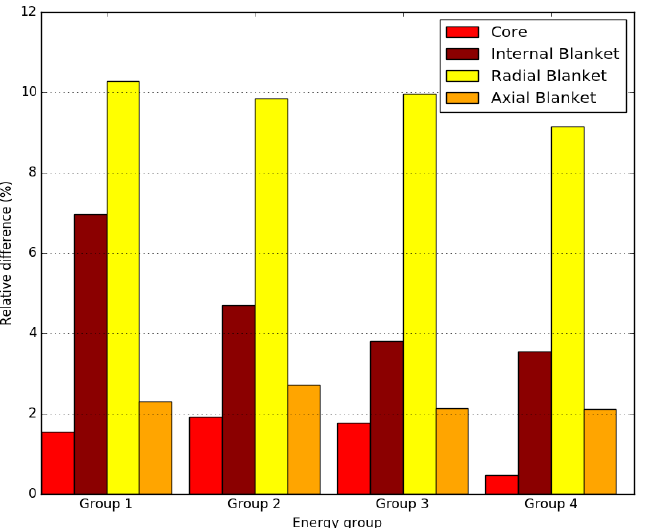
Figure 17. Comparison of region-averaged flux from reference and Parafish Model 3 Case